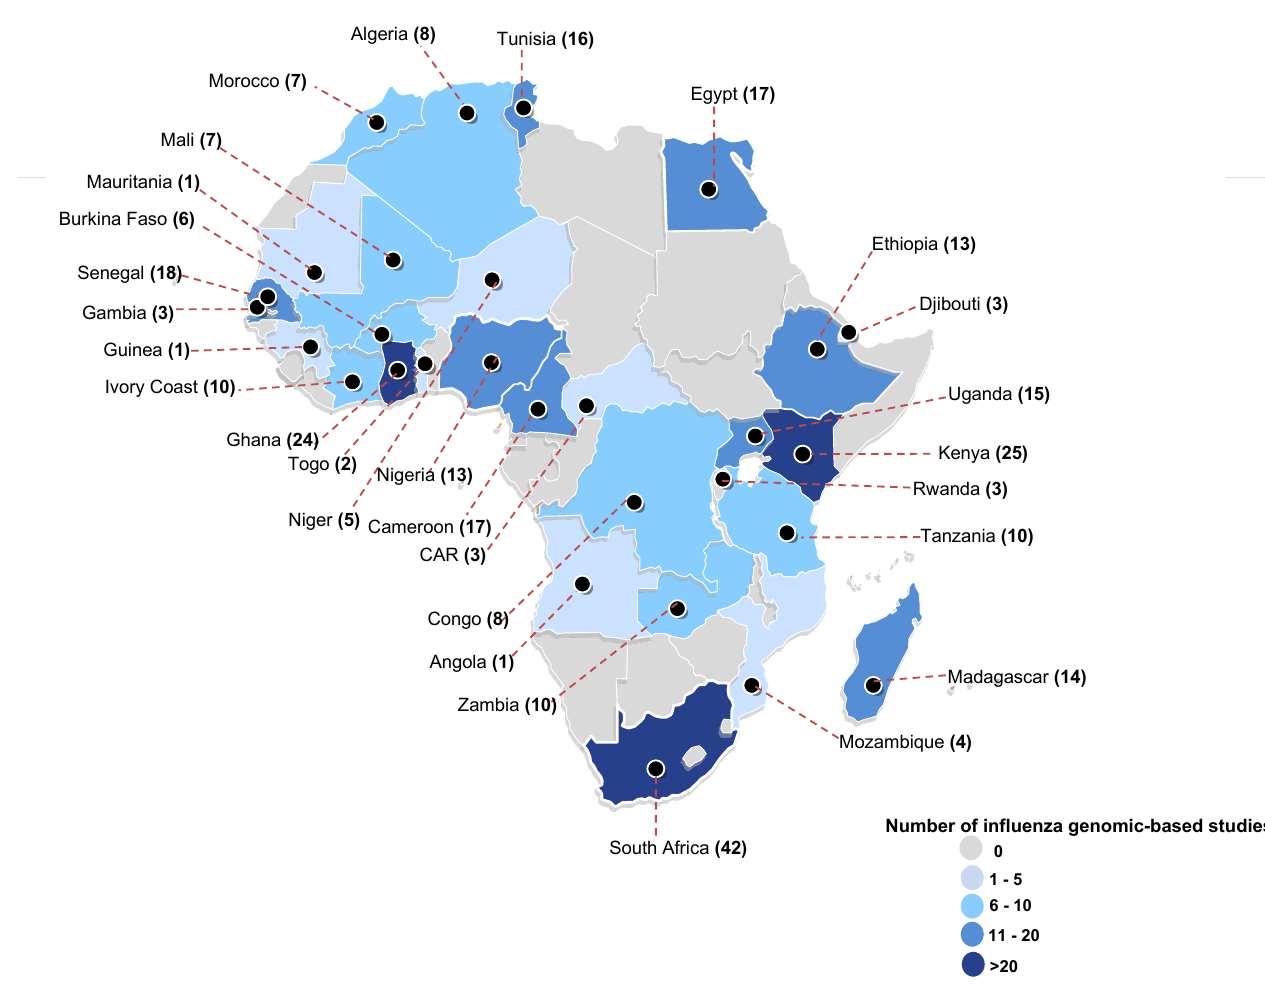
Figure 2. The geographical distribution of studies that did genomic characterization of influenza type-A viruses (H1N1, H1N1pdm09, and H3N2) sampled in Africa. Each country is highlighted based on the absolute number of studies that analyzed sequences of influenza viruses collected from that country. For each country, the study count also includes any study that included at least one sequence from that country in their virus clade classification using the European Center for Disease Control (ECDC) guidelines [27]. Abbreviations: CAR = Central African Republic. Countries not shown: Cape Verde ( n = 1), Reunion ( n = 3), Seychelles ( n = 4), Mauritania ( n = 1), Mauritius ( n = 10), and Mayotte ( n =